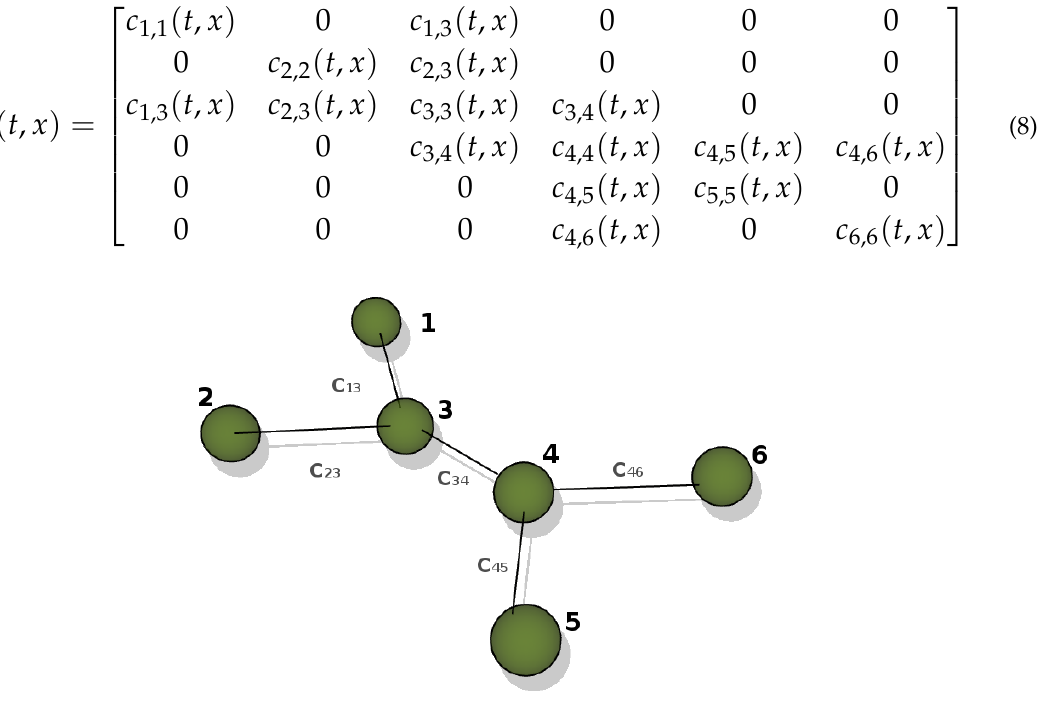
Figure 1. Network topology with varying couplings